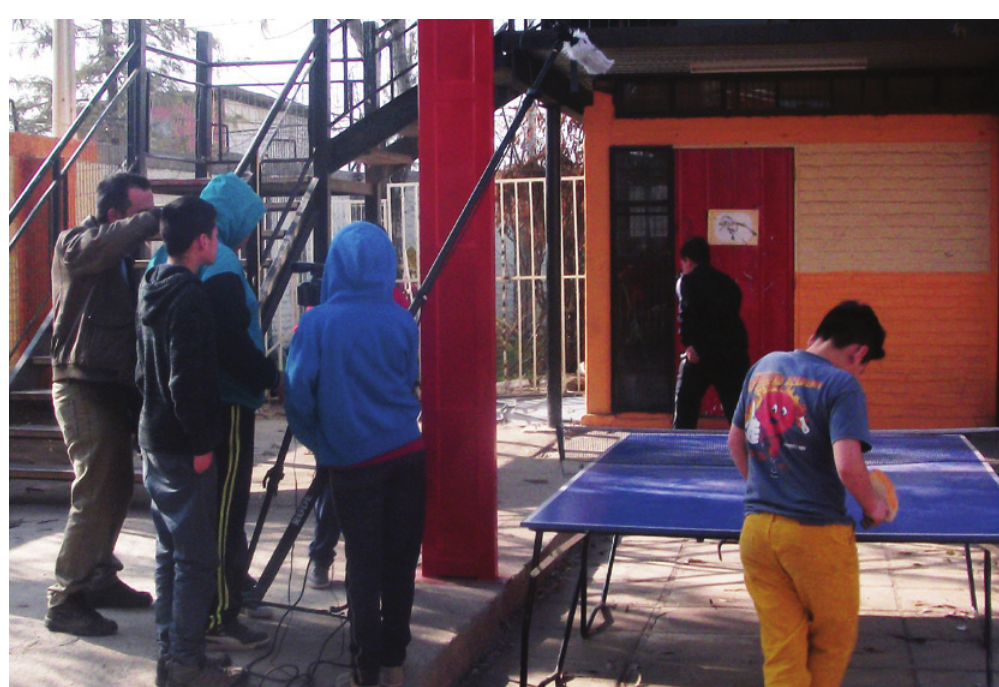
Figure 3: Introduction of filming equipment: Camera, tripod and sound